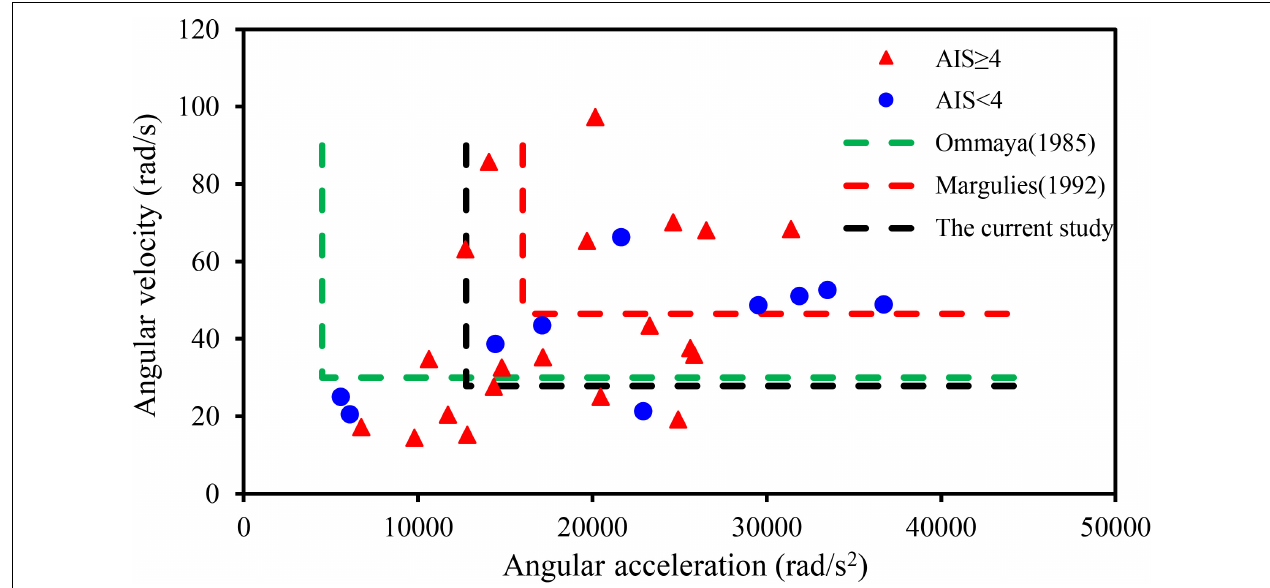
FIGURE 5 | The relationship between head angular velocity, angular acceleration, and brain